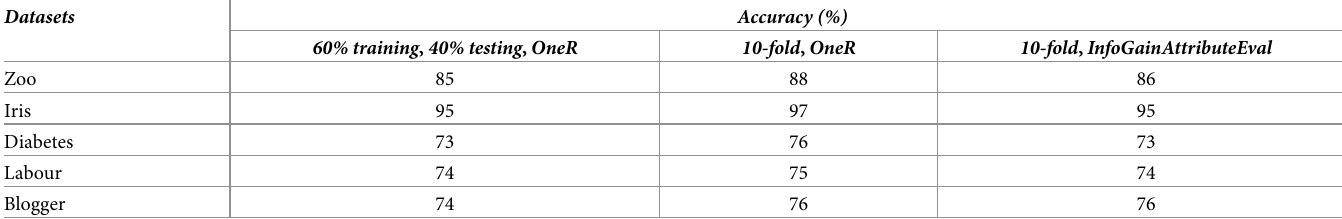
Table 4. Accuracy of PBMR with OneR and InfoGainAttributeEval attribute evaluators. Datasets